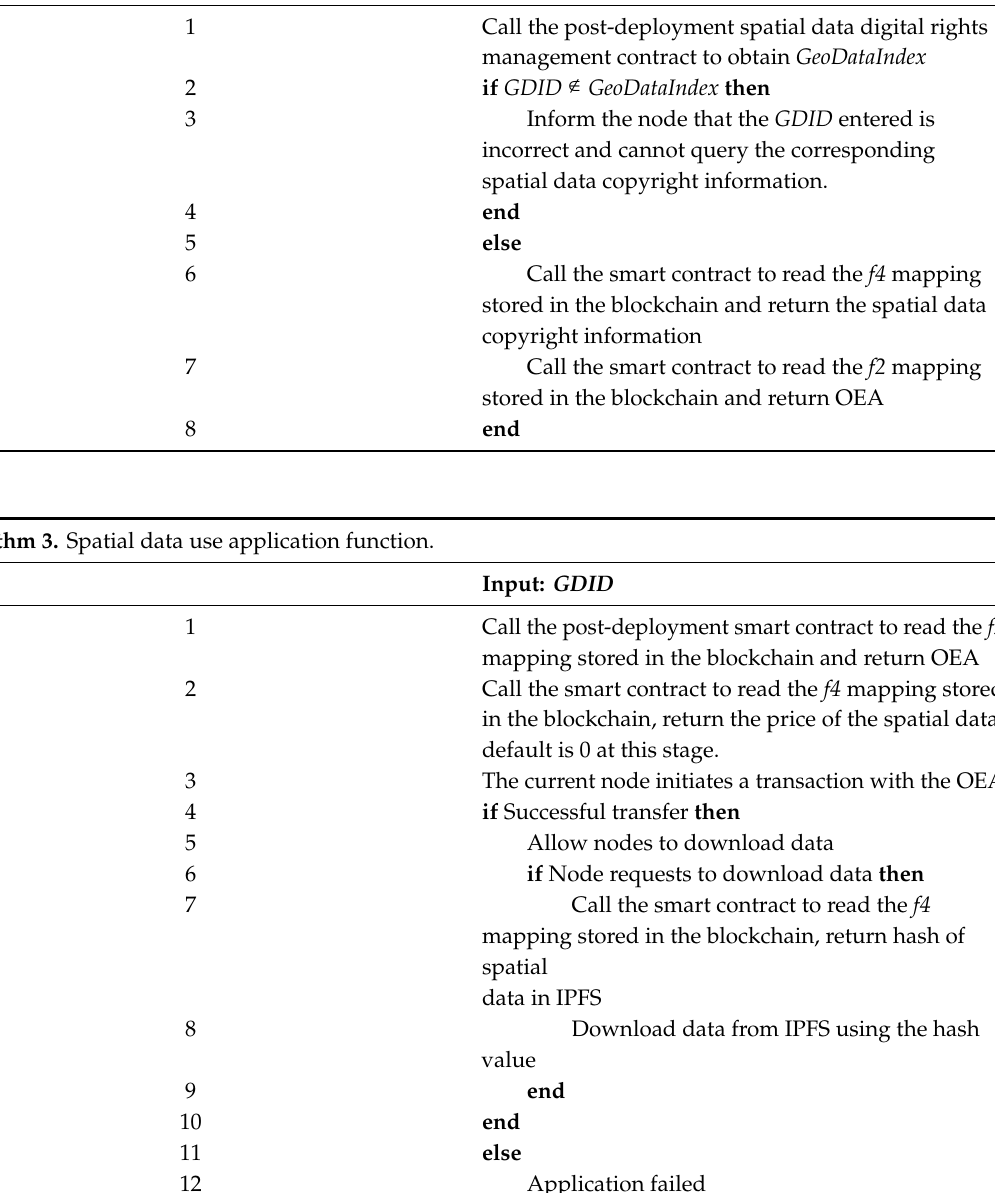
Algorithm 2. Spatial data copyright query function.